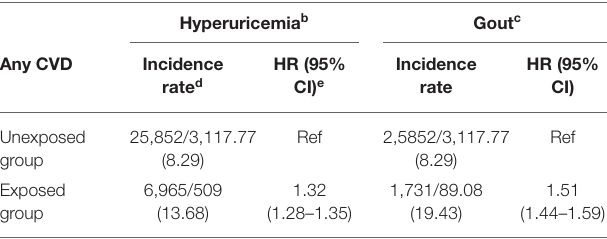
TABLE 2 | Incidence rate and hazard ratios of any cardiovascular disease (CVD) a among patients with studied hyperuricemia or gout when compared with patients without hyperuricemia and